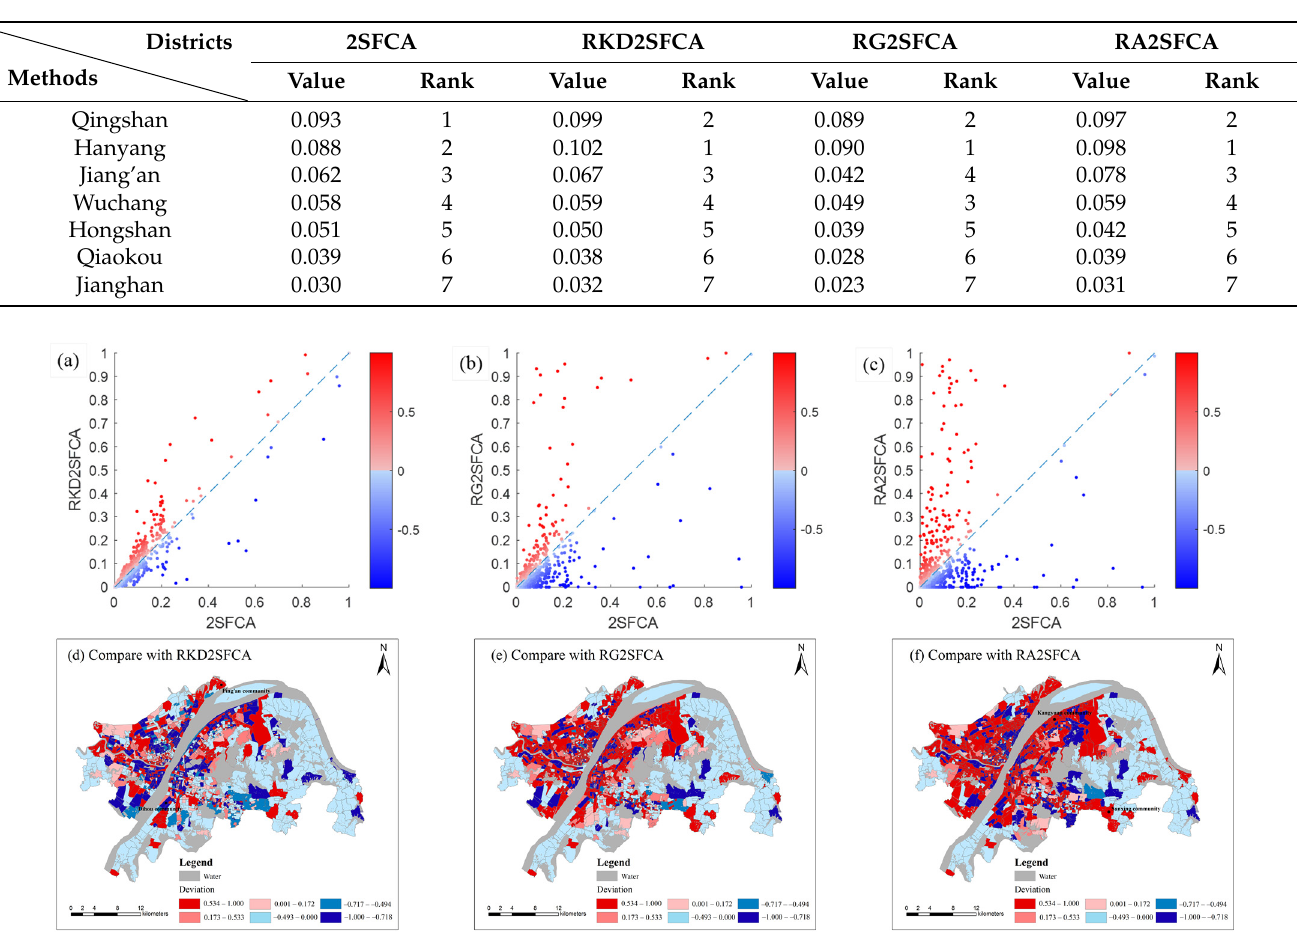
Table 1. Average accessibility value and the rank of park green space in various districts of Wuhan.